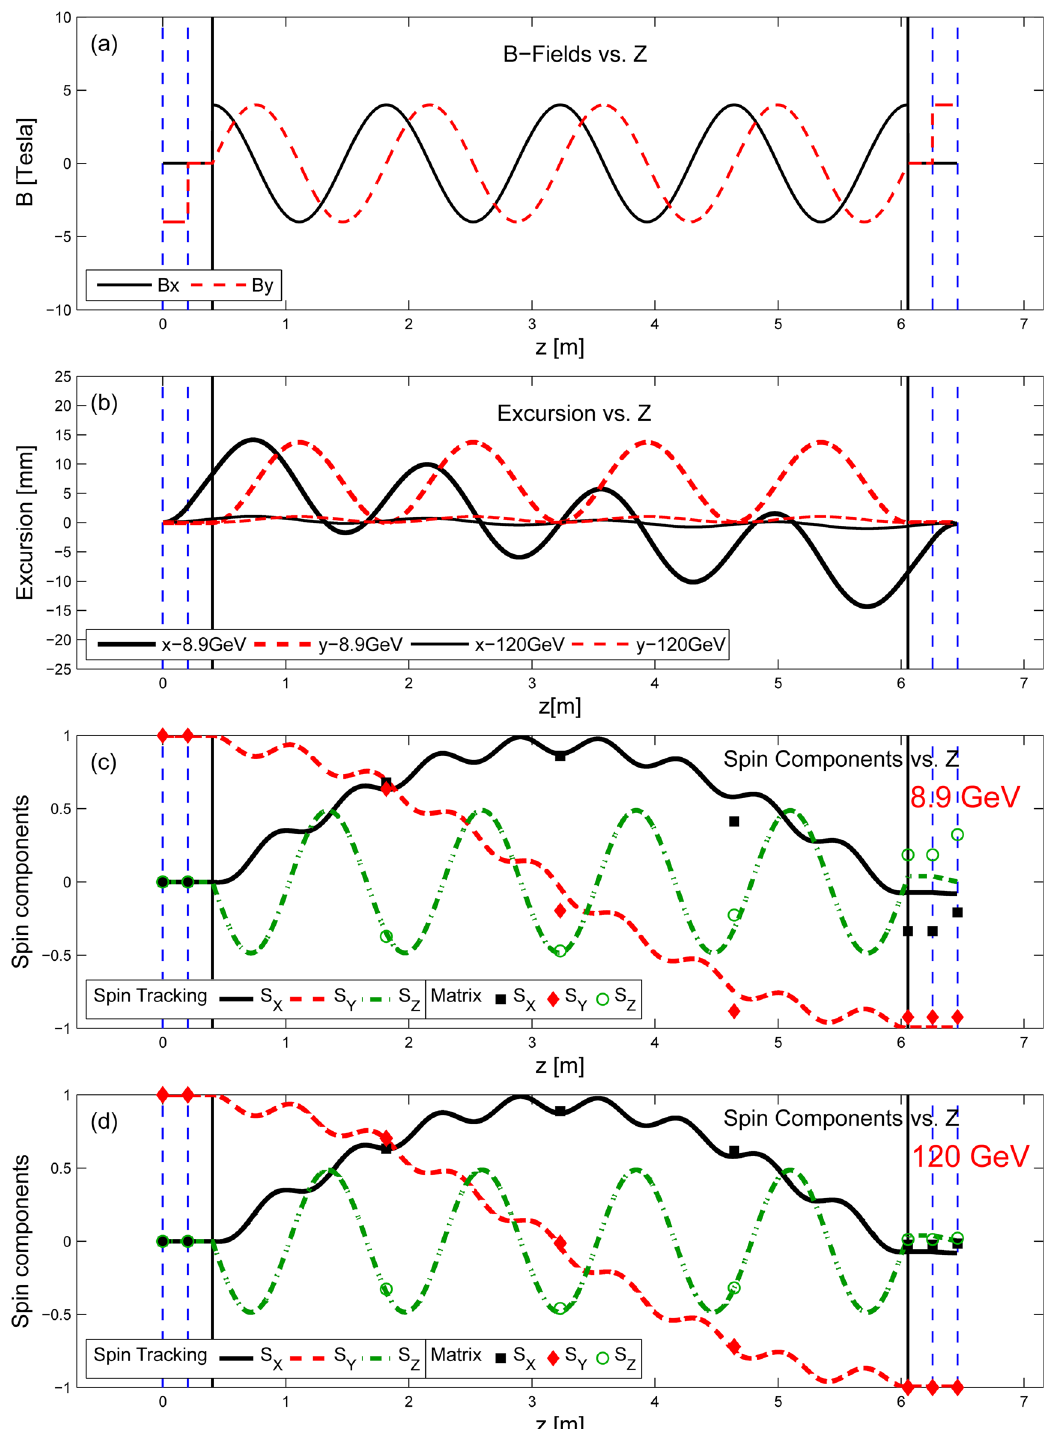
FIG. 1. (a) Horizontal and vertical field components for a Siberian Snake consisting of: 4-T – 4-twist – 5.653 m – long helical dipole, 4-T – 0.203 m – long dipoles at each end and two 0.200 m-long gaps [2]. Vertical lines show the helix ’ s edges (solid black) and the dipoles ’ edges (dashed blue). In the graphs, the curves are from a Python-based spin and excursion tracking program, the symbols are for analytic matrix calculations. (b) Horizontal and vertical orbit excursions. (c) Radial, vertical, and longitudinal spin components for a 8 . 9 GeV = c beam. (d) Spin components for a 120 GeV = c beam. Note that while numerical calculations can give us spin orientation anywhere inside the snake, the matrix calculations are only available for the end of each magnet. Note the much better agreement between our numerical and matrix calculation at 120 GeV = c than at 8 . 9 GeV = c. Fortunately a polarized proton beam spends almost all of its time at or near its final energy; the depolarization near 8 . 9 GeV = c should be much